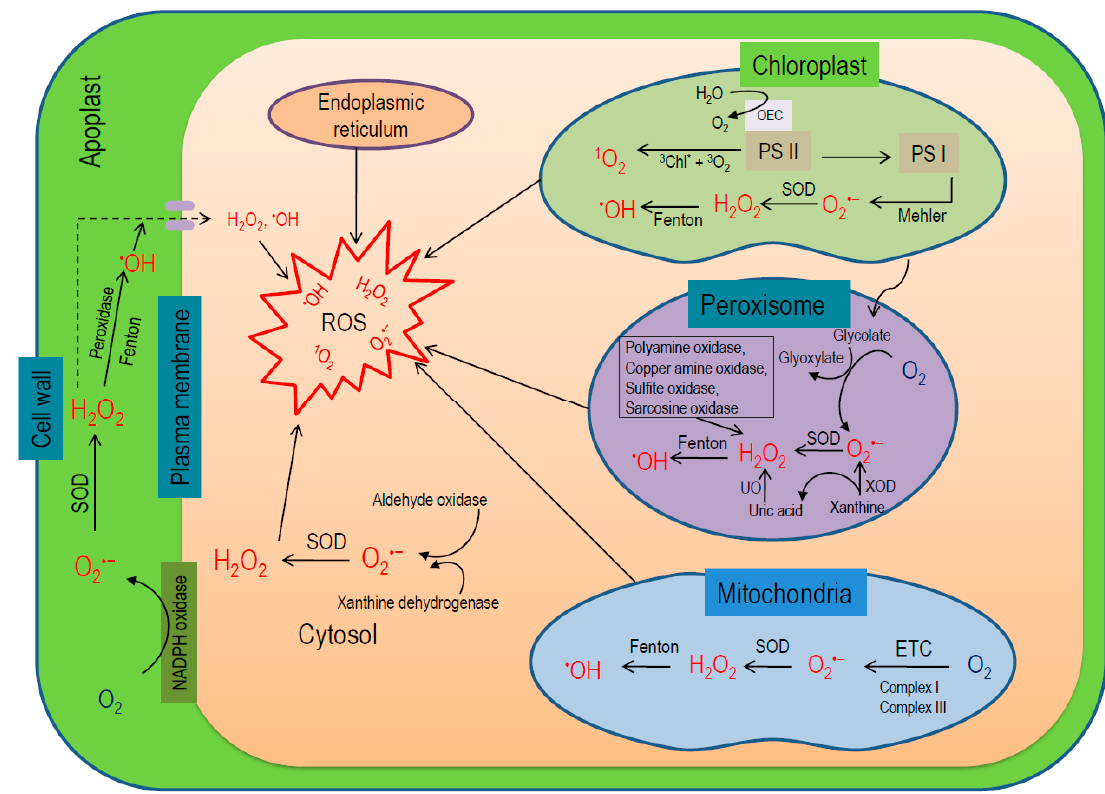
Figure 3. Localization and processes for the generation of ROS in plant cells (ROS, reactive oxygen species; H 2 O 2 , hydrogen peroxide; O 2 •− , superoxide anion; 1 O 2 , singlet oxygen; • OH, hydroxyl radical; SOD, superoxide dismutase; UO, urate oxidase; XOD, xanthine oxidase; ETC, electron transport chain; PS I, photosystem I; PS II, photosystem II; NADPH, nicotinamide adenine dinucleotide phosphate).